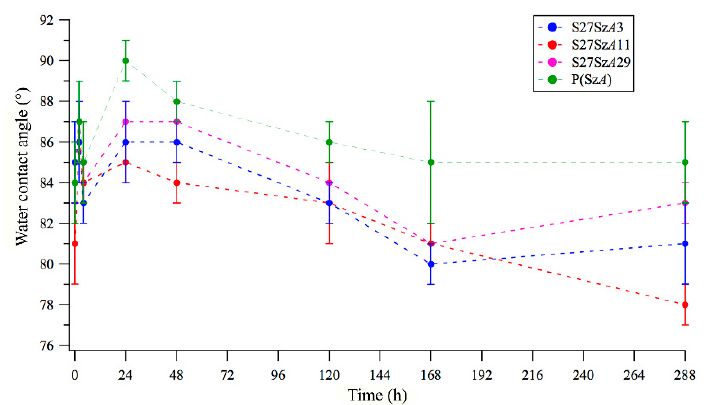
Figure 4. Water static contact angle as a function of immersion time in water.